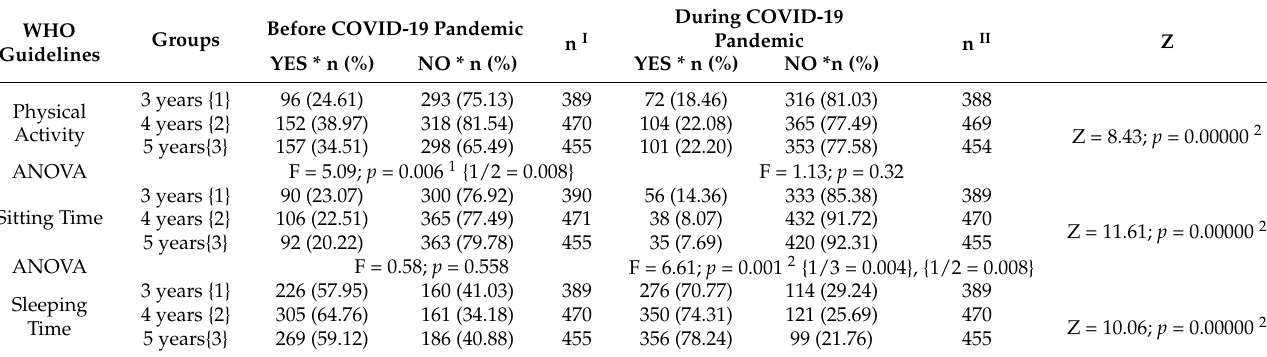
PA, sitting, and sleeping